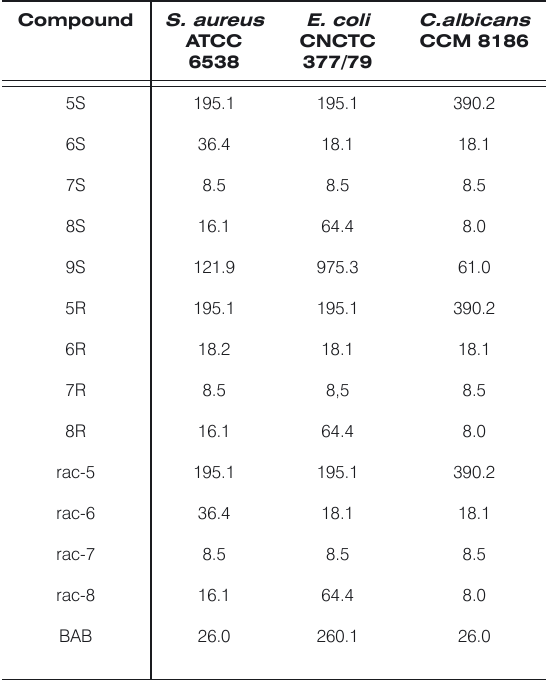
Table 3. The MBC valuesa of prepared QUATs